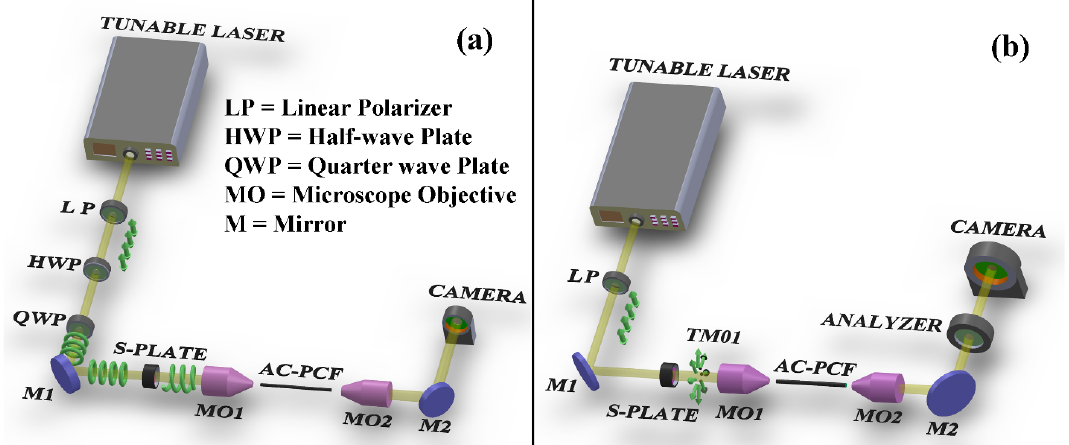
Figure 2. Experimental setup for launching and imaging ( a ) orbital angular momentum (OAM) beams and ( b ) cylindrical vector beams (CVB) (TE 01 and TM 01 ) in the